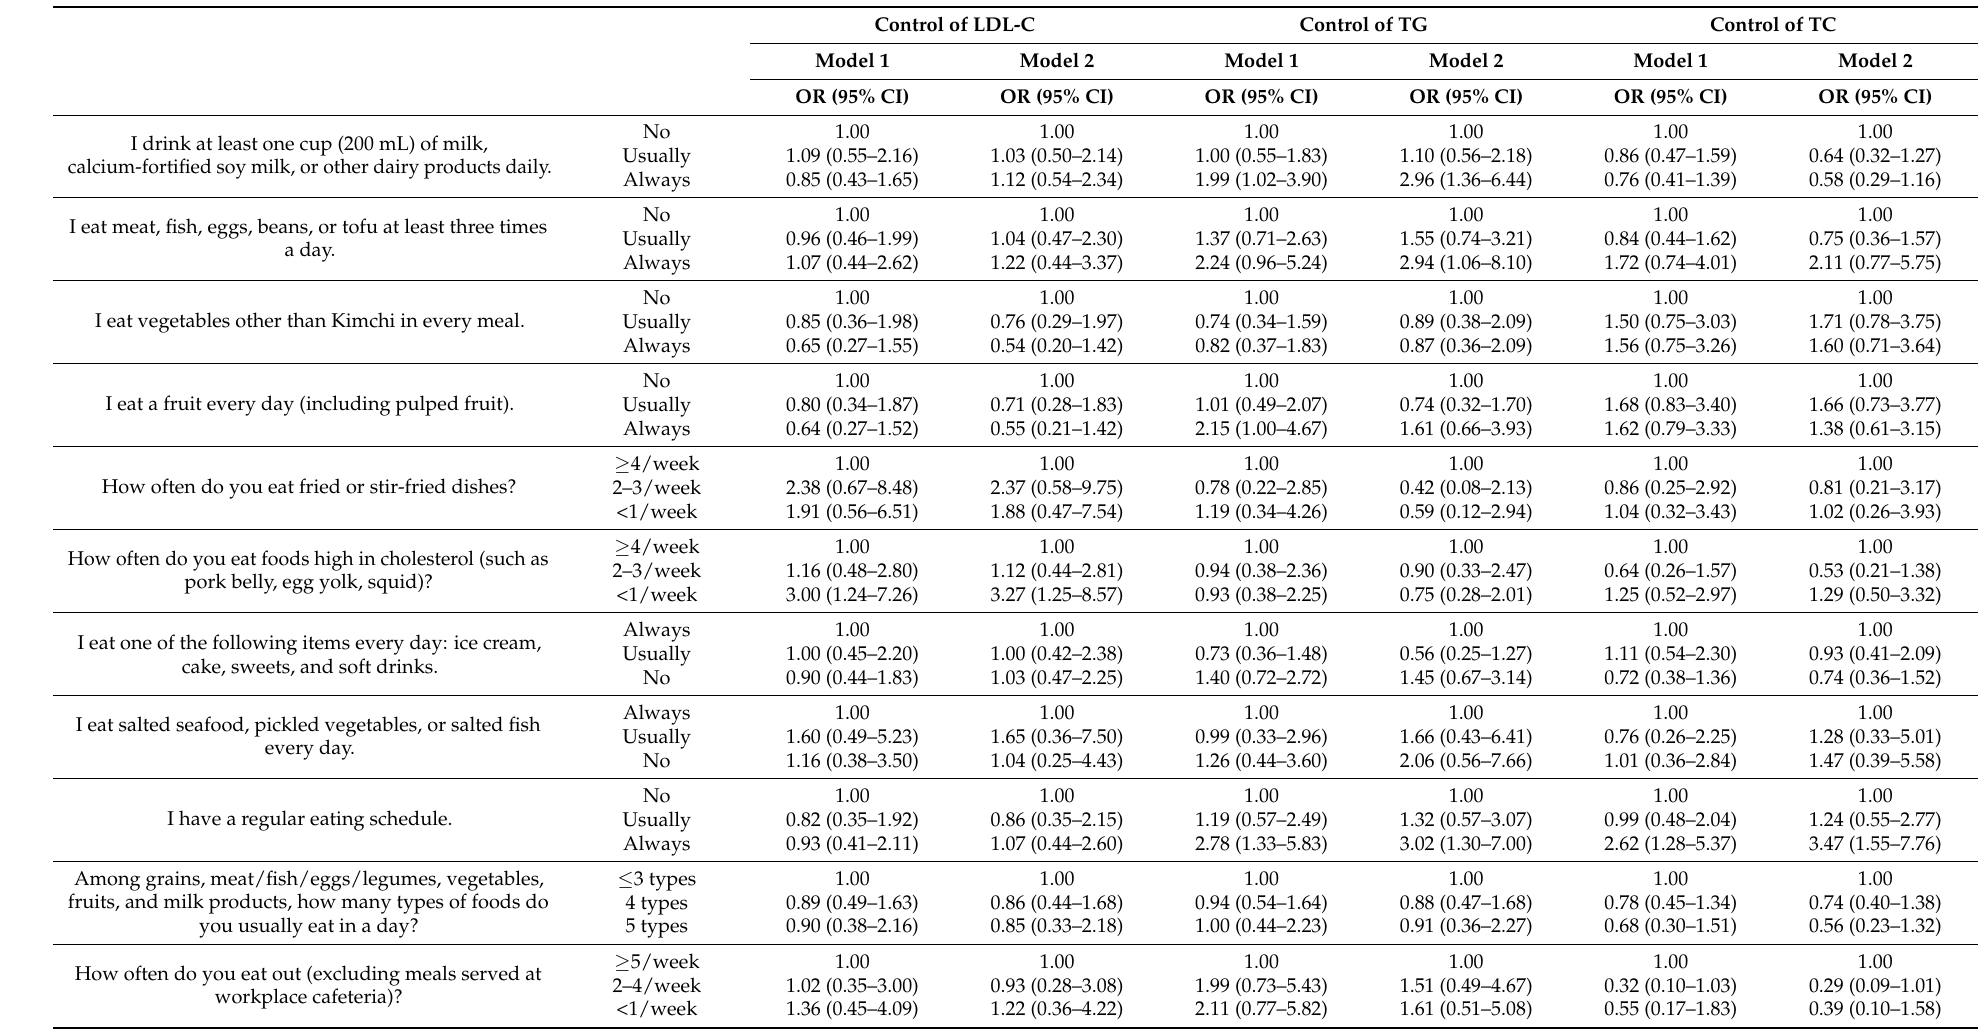
Table 4. Multivariate association between dietary habits and the control of LDL-C, TG, and TC at 6 months. Control of LDL-C Control of TG Control of TC Model 1 Model 2 Model 1 Model 2 Model 1 Model 2 OR (95% CI) OR (95%